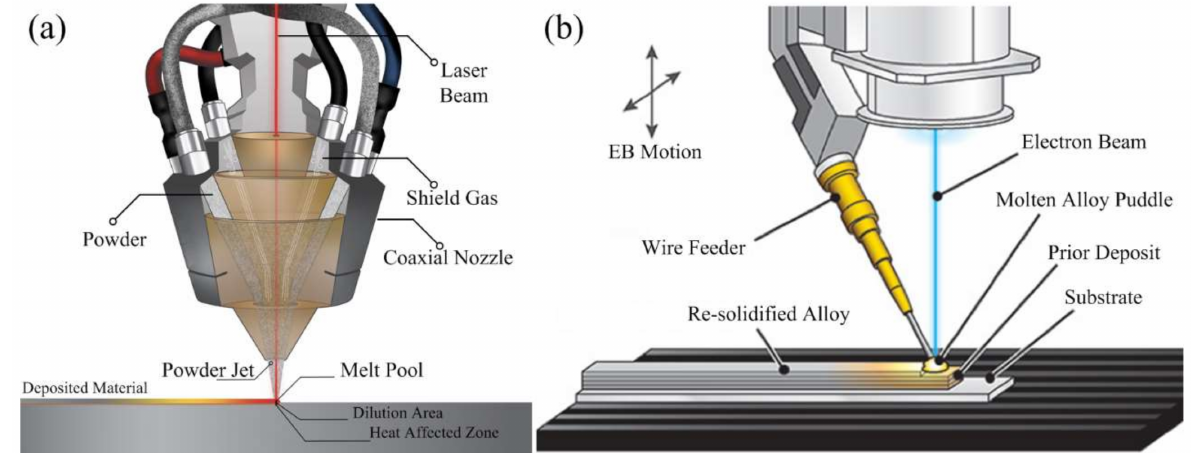
Figure 4. Directed Energy Deposition (DED): ( a ) Powder DED (laser source) [17]; ( b ) Wire DED (E-beam source) [18].